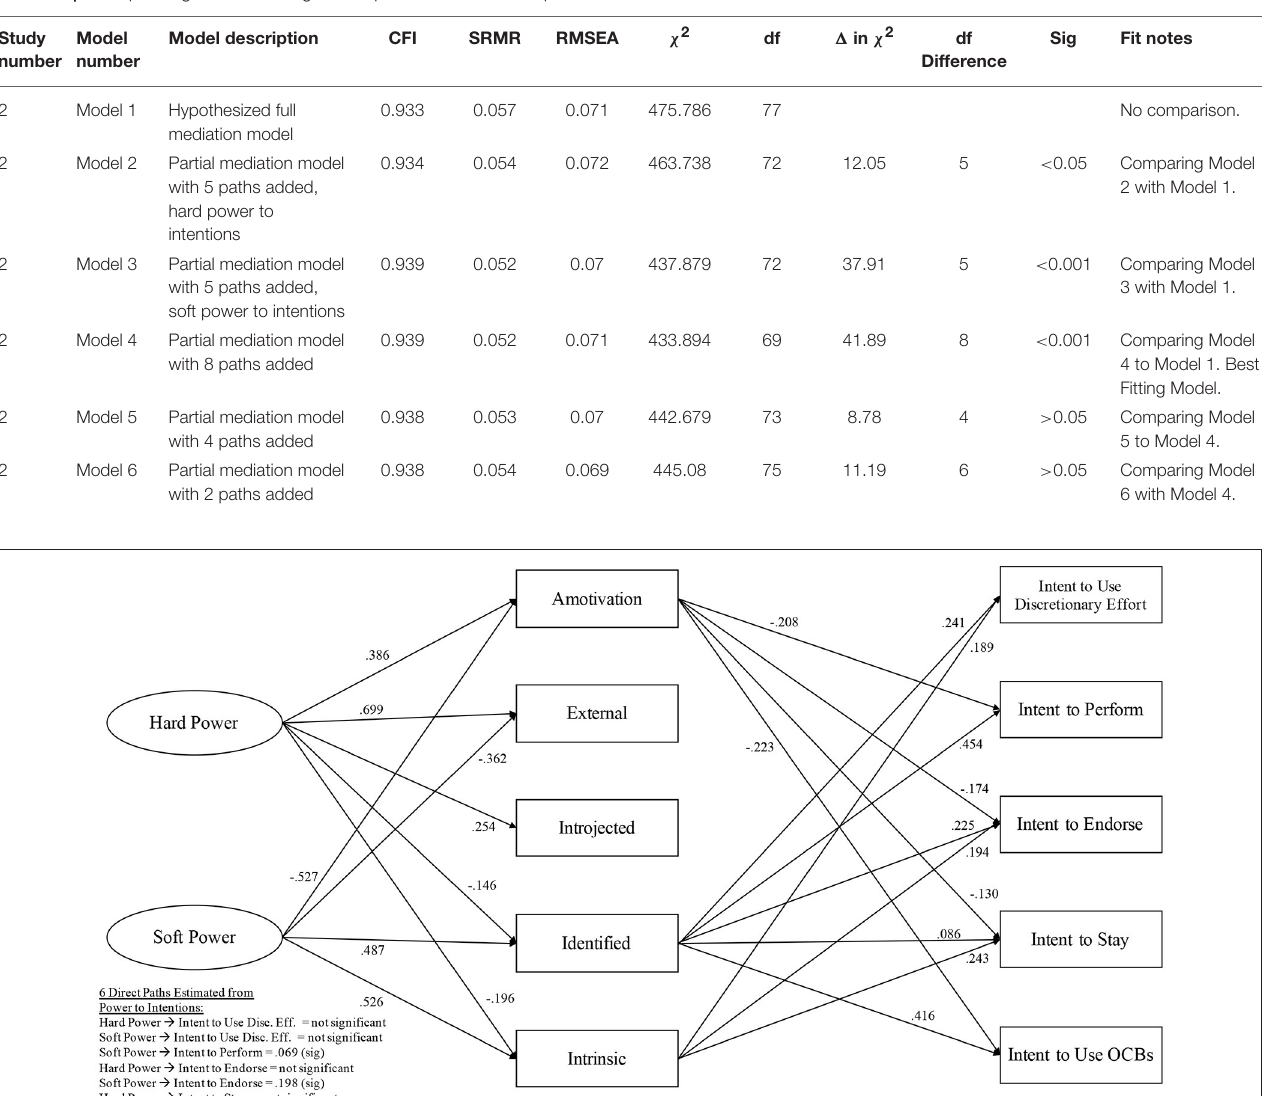
TABLE 5 | Chi-square significance testing for comparison of structural equation model fit.